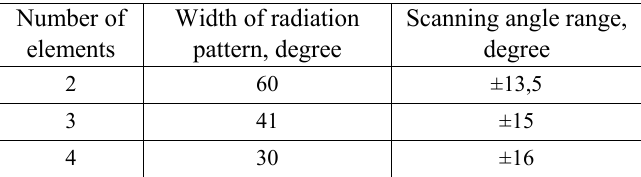
Table 1. Characteristics of low-element antenna